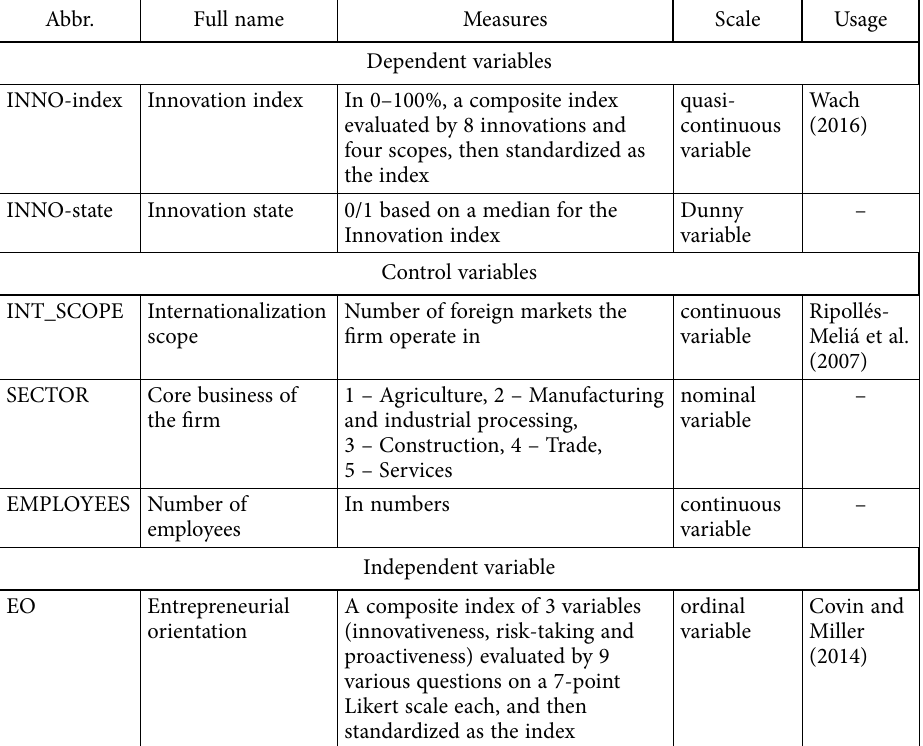
Table 1. Used variables (source: own elaboration)